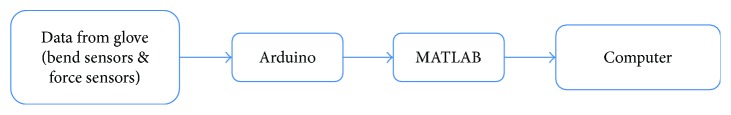
Hardware setup of the bend and force sensors for hand motion analysis.